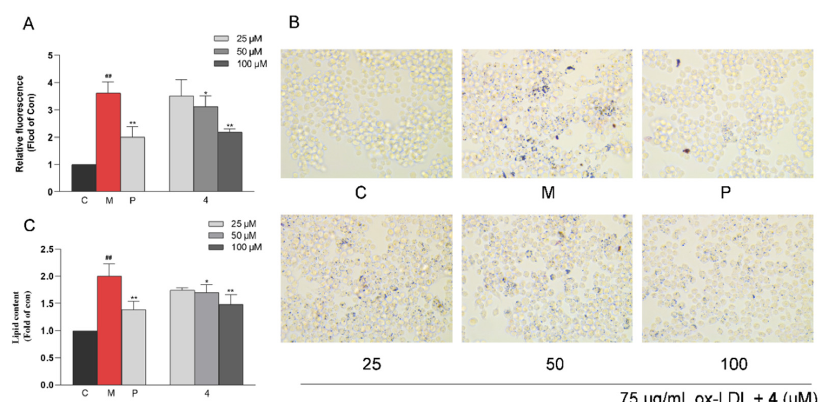
Figure 9. Inhibitory effect of compound 4 on intracellular lipid accumulation in RAW264.7 cells. ( A ) Intracellular lipid contents were measured by the fluorescence intensity at an excitation/emission wavelength of 530/560 nm. ( B ) Oil Red O staining images of RAW264.7 cells (magnification 400×). ( C ) Quantitative Oil Red O content at 550 nm. Data are expressed as the mean ± SD ( n = 3). Statistical analysis: ## p < 0.01 vs. the control group; * p < 0.05; and ** p < 0.01 vs. the ox-LDL-treated model group. C: control group, M: model group, and P: positive group.